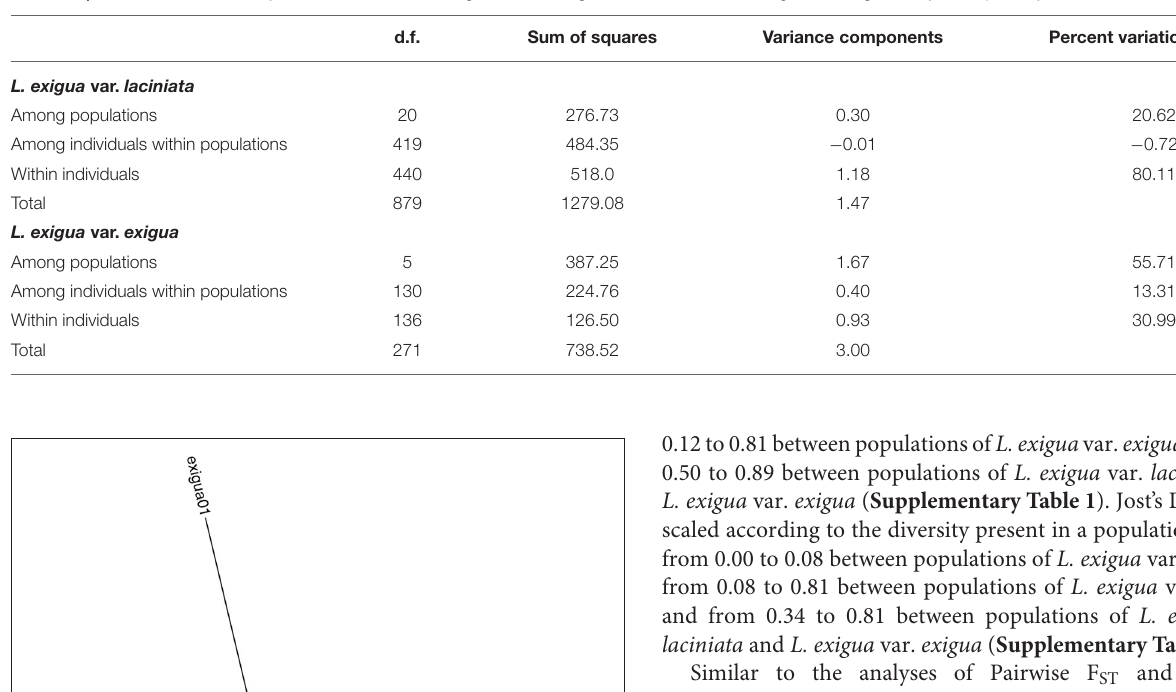
which was separated by a long branch from populations of L. exigua var. exigua, with populations of L. exigua var. exigua also separated by longer branches ( Figure 3 ). Of the L. exigua var. exigua populations, the Exigua 04 population was placed as the most genetically similar to L. exigua var. laciniata , and the